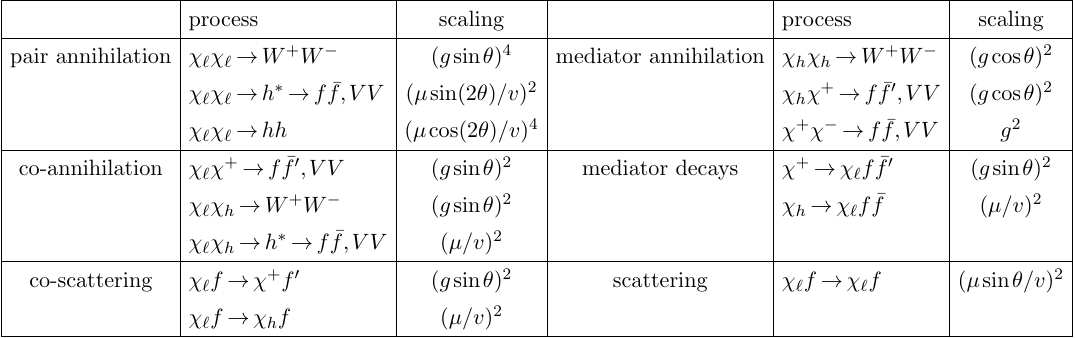
Table 1 . Dark fermion processes around freeze-out and how their rates scale with the Higgs-portal coupling (cid:22)=v and the fermion mixing angle (cid:18) . Standard-model fermions and vector bosons are denoted by f; f 0 and V